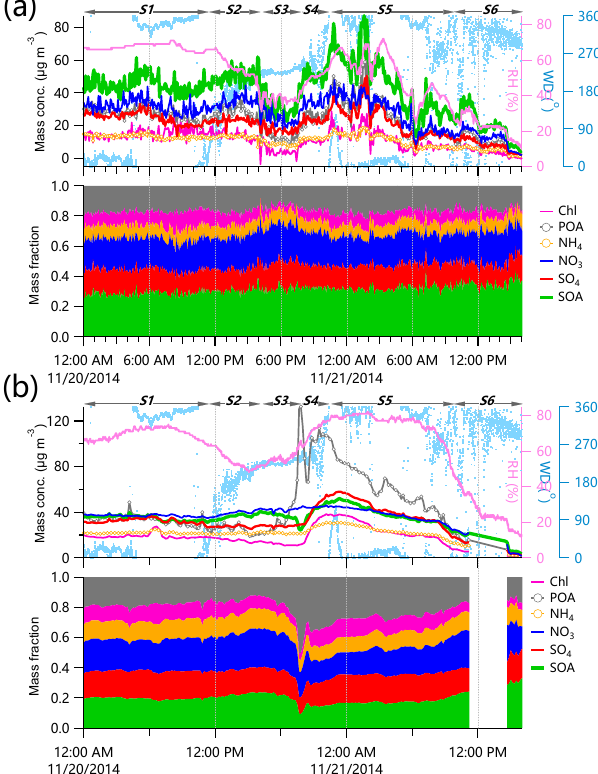
Figure 6. Evolution of nonrefractory submicron aerosol species and NR-PM 1 composition at (a) 260m and (b) ground level. POA (FFOA + COA + BBOA) and SOA (LO-OOA + MO-OOA) were from positive matrix factorization of OA. RH and WD are also shown for a